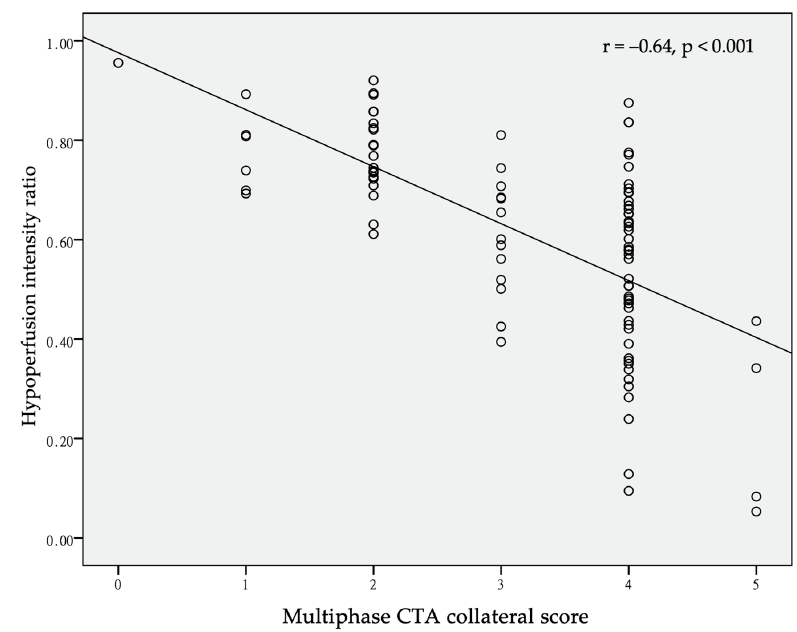
Figure 2. Scatter plot of hypoperfusion index (HIR) and multiphase CT angiography (mCTA) collateral score. Pearson’s r = –0.64, p < 0.001.